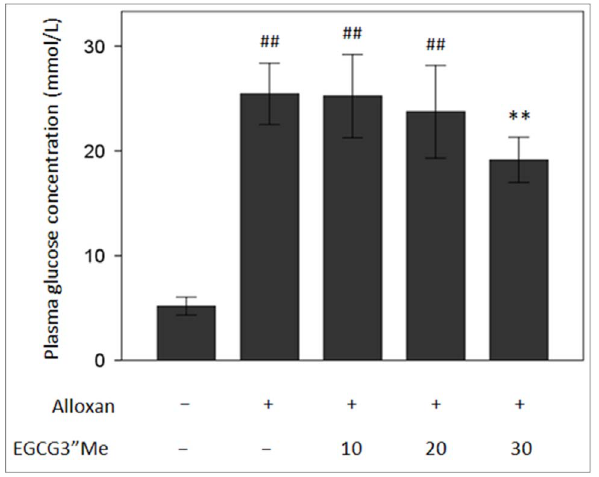
Figure 3. Effects of EGCG3’’Me extracts on the blood glucose of diabetic mice. ## represents the statistical significance vs. control group; **represents the statistical significance vs. diabetes model, n=6 to 8.